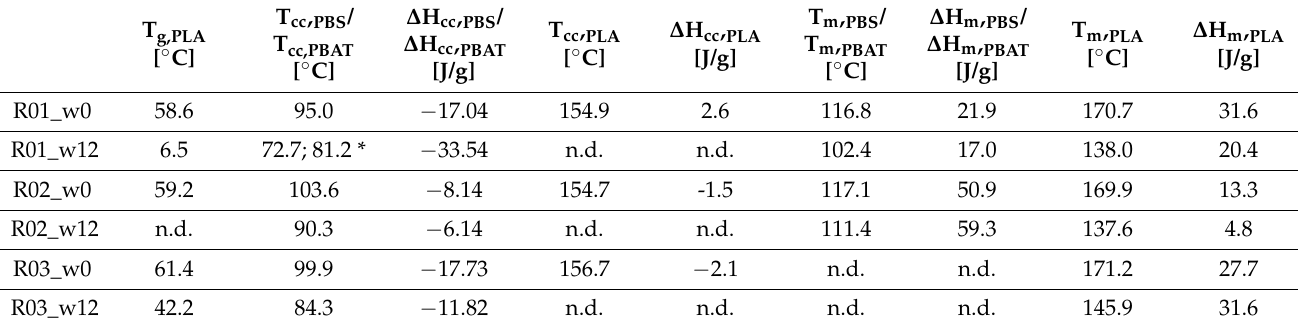
Figure 2. Differential scanning calorimetry (DSC) curves from unfilled blend systems before and after 12-week composting period. Compositions: R01: PLA/PBS (7:3); R02 PLA/PBS (3:7); R03: PLA/PBAT (7:3). Table 2. Thermal values from unfilled blend systems before and after